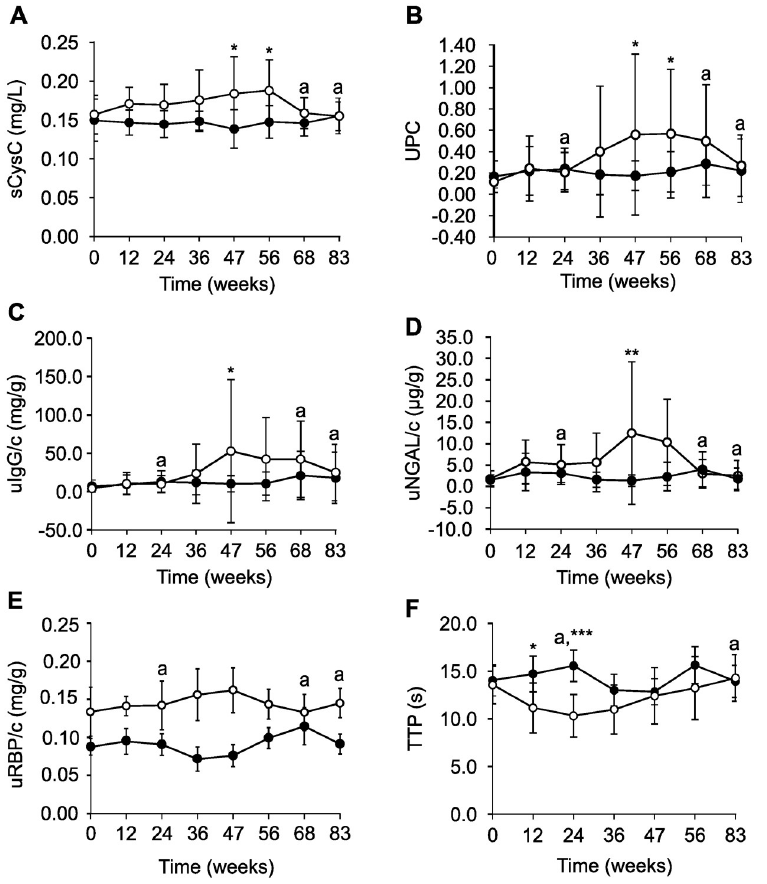
Fig 5. Kidney-related parameters of beagles in the control group (closed circles; n = 8) and in the weight-change group (open circles; n = 8) during the weight-gain phase (week 0–47), weight-stable phase (week 47–56) and weight-loss phase (week 56–83). Serum cystatin C (sCysC, A), a biomarker of kidney function; urinary protein: creatinine (UPC) (B), urinary immunoglobulin G:creatinine (uIgG/c, C), a biomarker of renal glomerular injury; and urinary neutrophil gelatinase-associated lipocalin:creatinine (uNGAL/c, D) a biomarker of renal tubular injury; urinary retinol-binding protein (uRBP/c, E) and time-to-peak (TTP) of the renal cortex, representing blood velocity, measured with contrast-enhanced ultrasound (F) are shown. a Data from one dog missing in the control group. ��� P = 0–0.001, �� P = 0.001–0.01 and � P = 0.01–0.05 for the group x time interaction, after multiple correction.